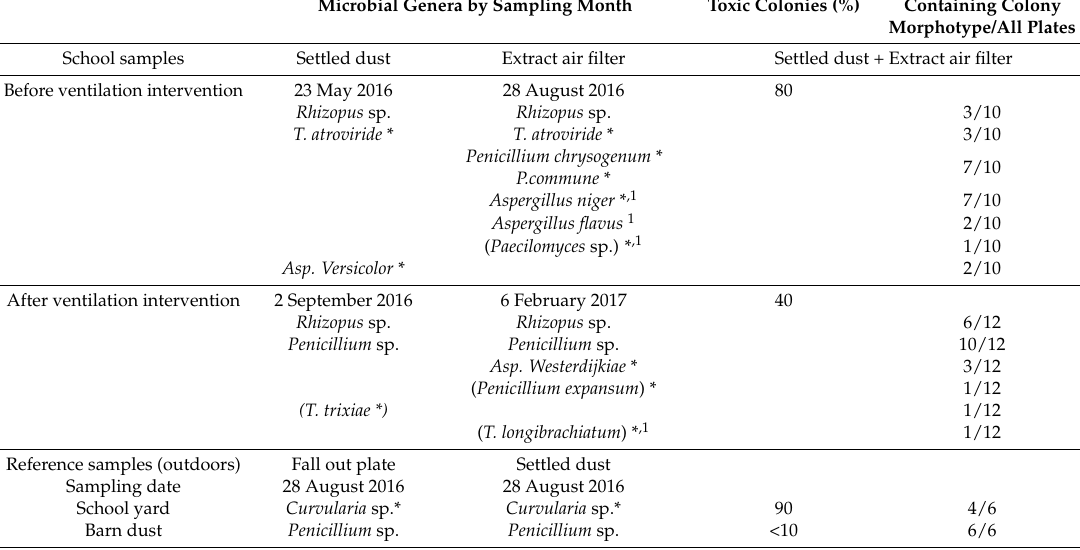
Table 8. Cultivable mycobiota in indoor dust from the extract air filter and from classroom surfaces above the floor level. The dust was sampled before and after the ventilation intervention. Names in brackets indicate the presence of a single colony on a single